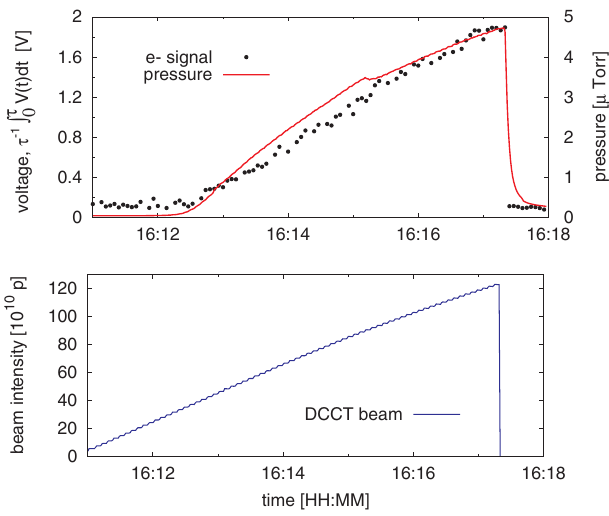
FIG. 6. (Color) Pressure and electron signal evolution (top plot), as the blue beam is being injected (bottom plot). Pressure and electron signal follow a similar Fig. 7, which validates the initial assumption in Eq. (4), and supports the idea of electron clouds as the driving mecha-